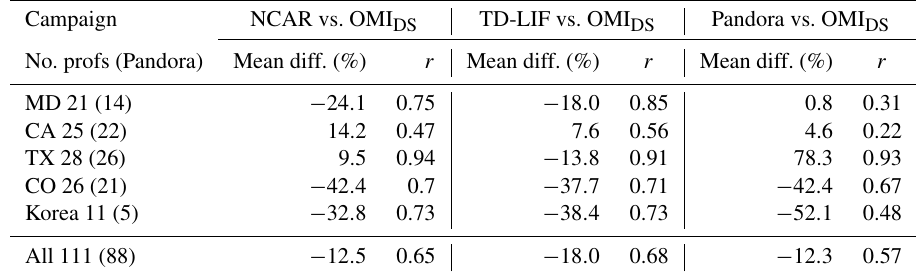
Table A4. Same as A2, but for OMI obs with downscaling (OMI DS ). Campaign NCAR vs. OMI